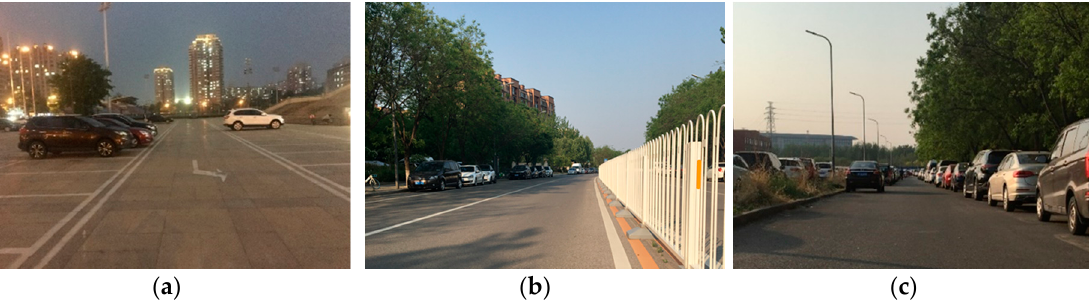
Figure 10. Three experimental scenes obtained by optical cameras ( a ) scene 1; ( b ) scene 2; ( c ) scene